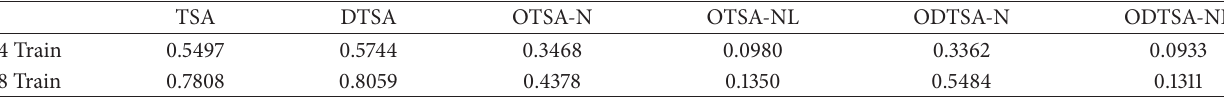
Table 5: Training time (second) on Yale database.